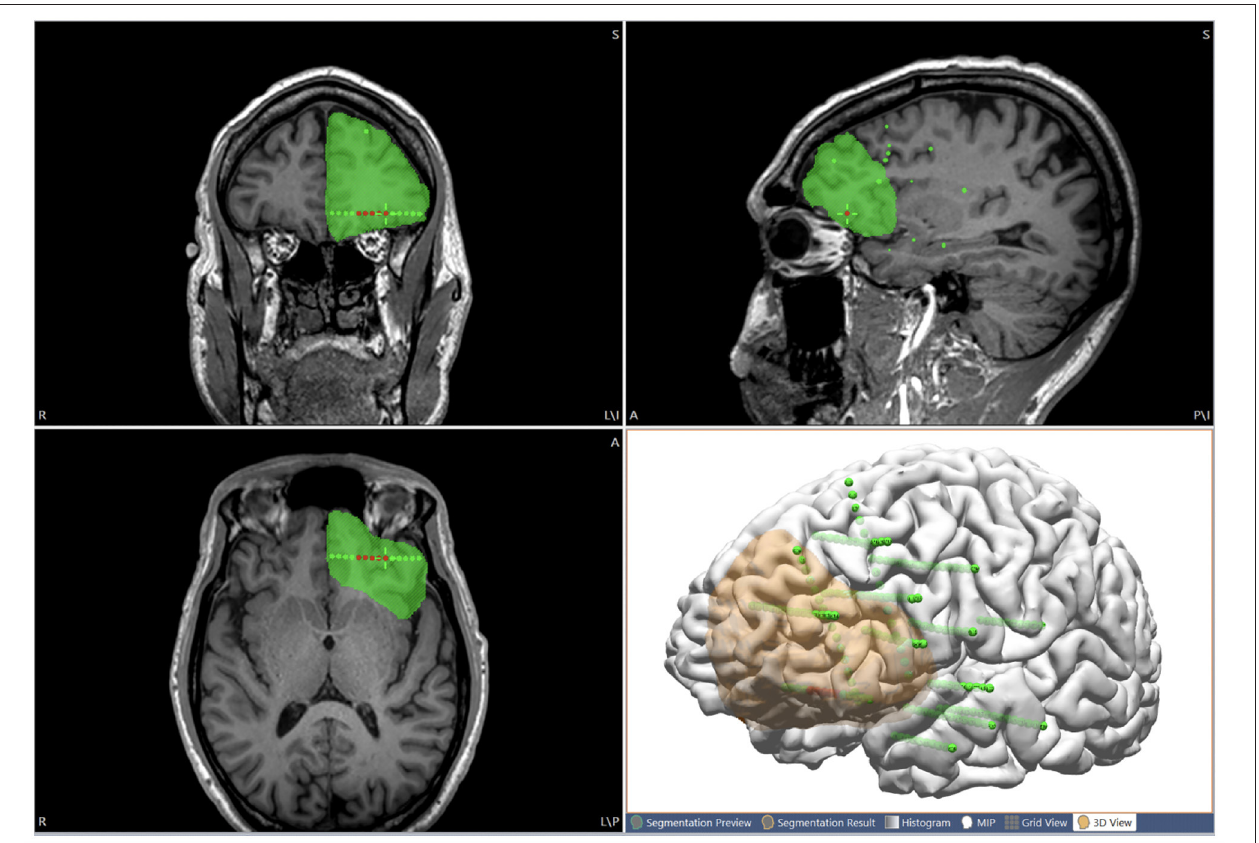
FIGURE 5 | Illustration of using the multimodal image integration workflow for planning resection. The proposed resection area is interactively drawn on the MRI (coronal, axial and sagittal views), and can also be shown in 3D view together with the cortical surface (orange region). Green spheres indicate all the implanted SEEG electrodes. Red spheres indicate seizure-onset contacts.